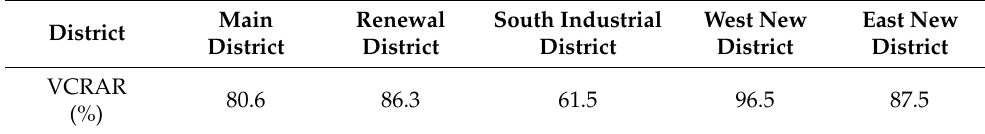
Table 6. VCRAR for Every District in Jizhou.